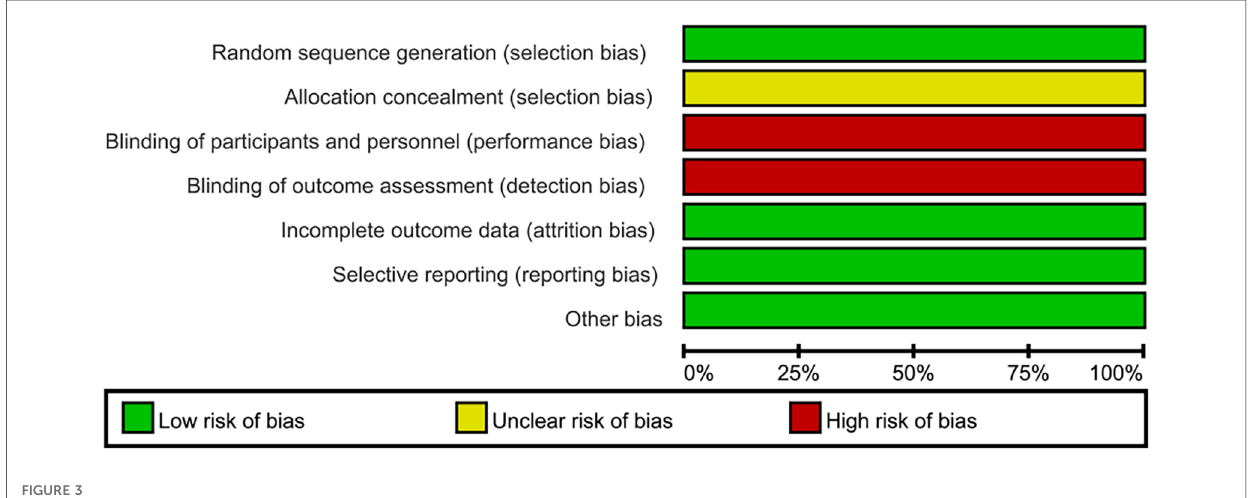
FIGURE 3 Risk of bias summary in the two RCTs.